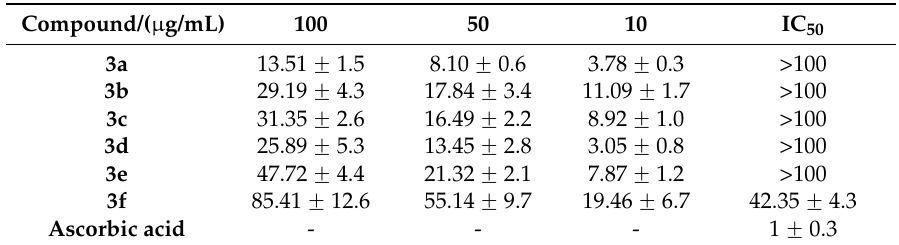
Table 4. Decoloration of DPPH solution by the synthesized compounds in comparison with ascorbic acid. Values are the average of triplicate experiments.